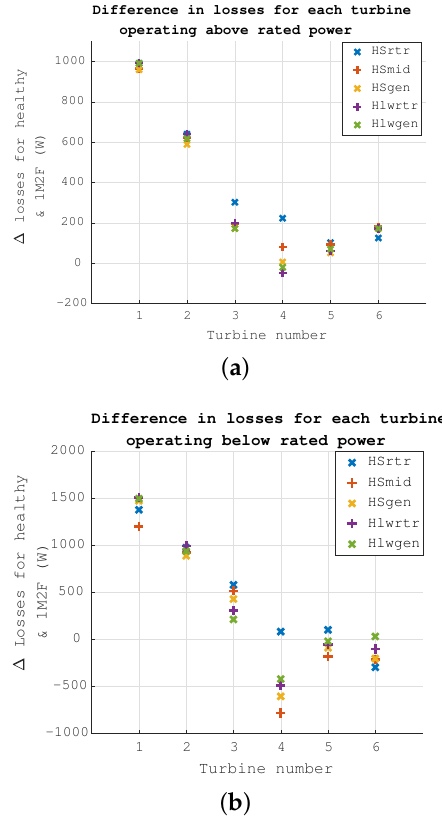
Figure 9. Dataset 2 thermal network model results above rated power data ( a ) and below rated power data ( b